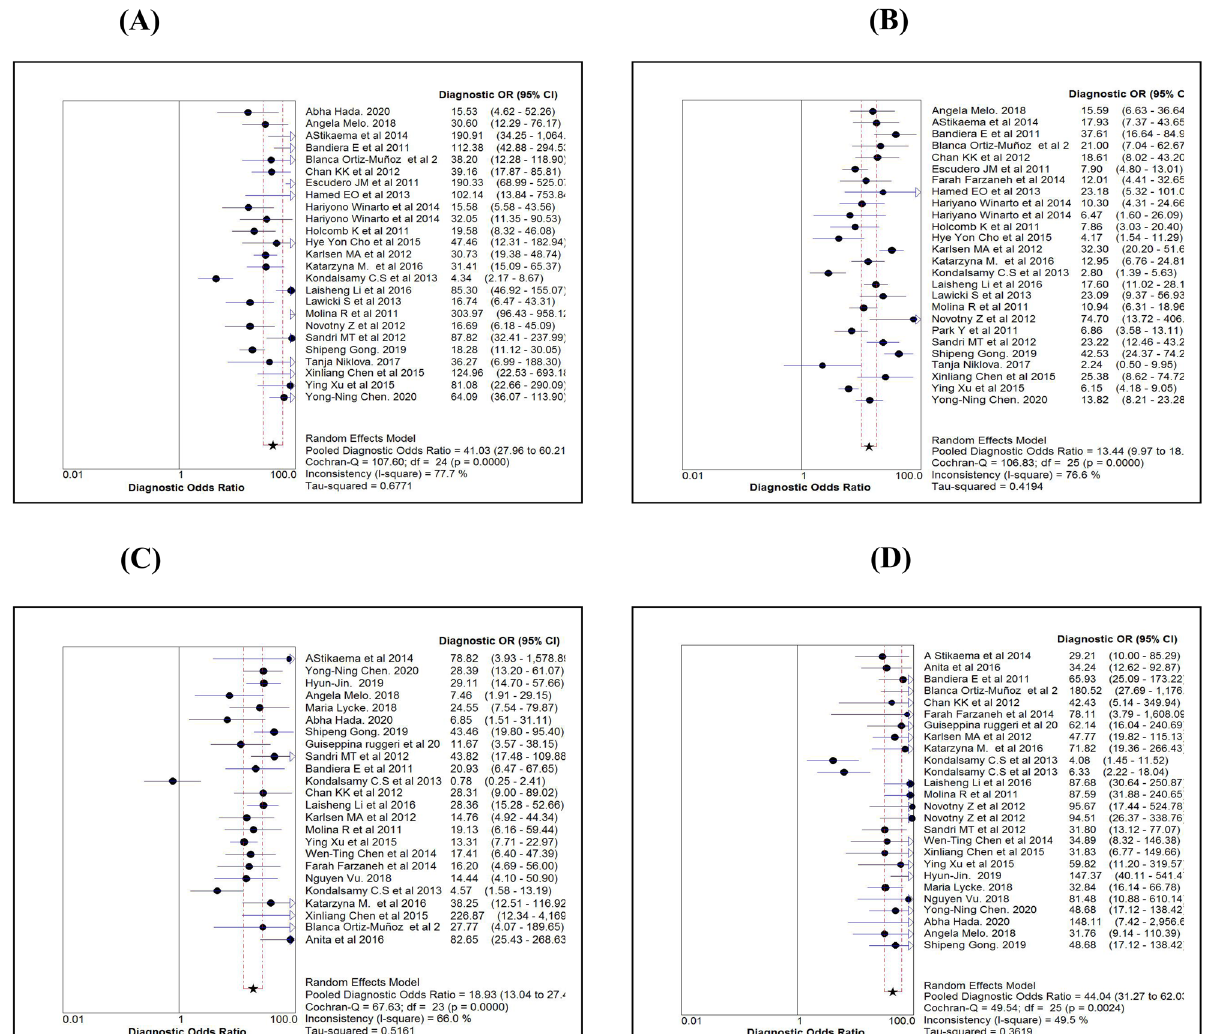
Figure 7. Comparison of diagnostic odds ratio estimates (using Random effect model) of HE4 ( A ), CA125 ( B ), ROMA for pre-menopause ( C ) and ROMA for post-menopause ( D